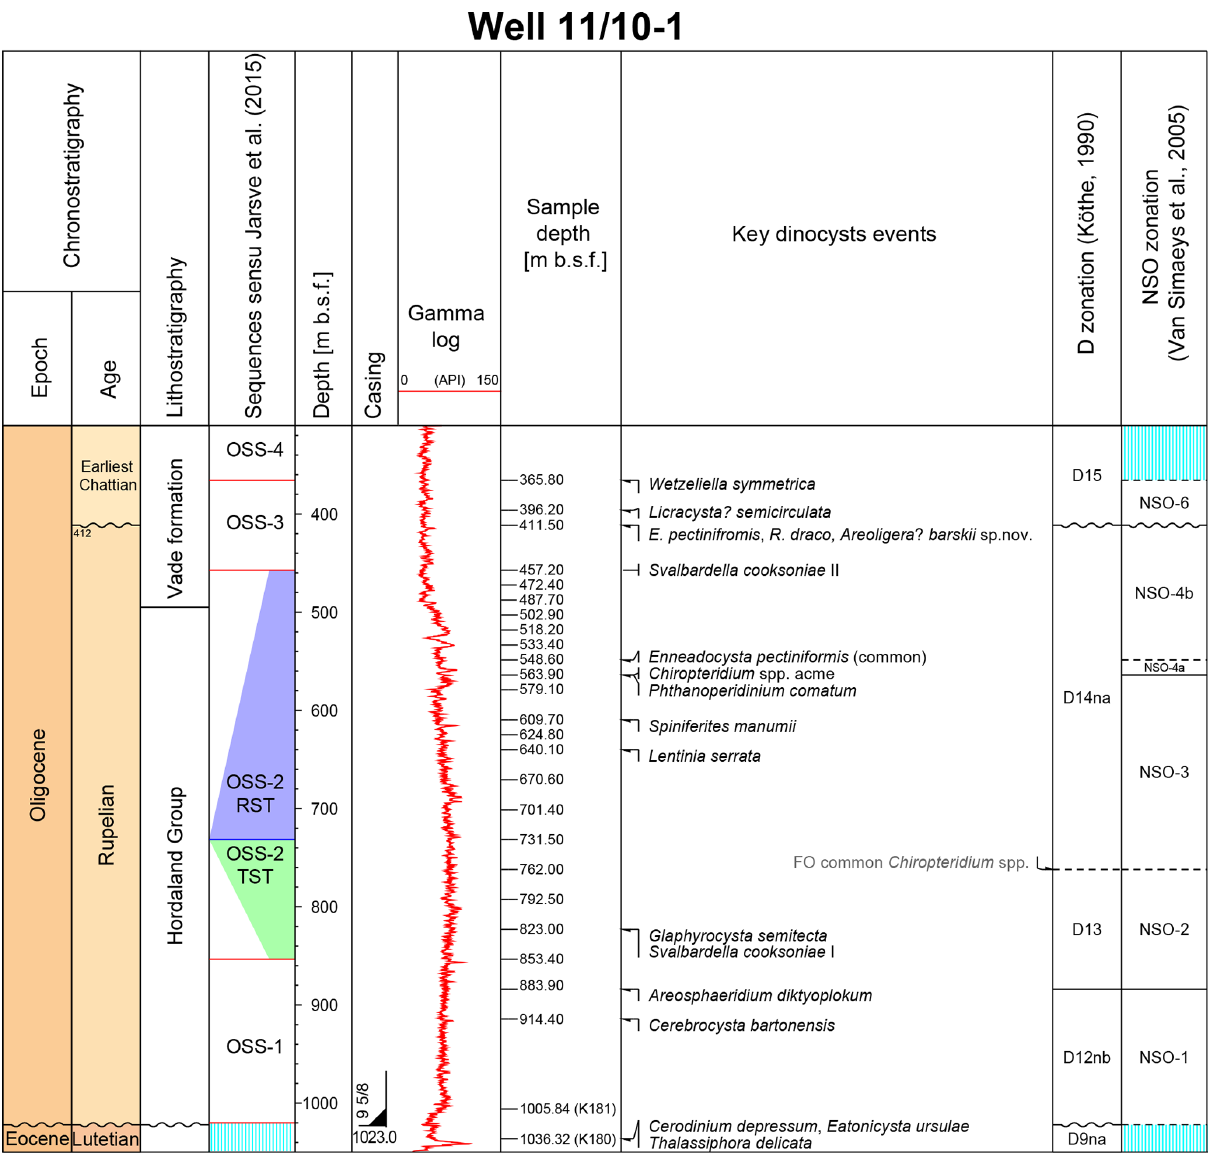
Figure 3. Chronostratigraphy (this study), lithostratigraphy and sequence stratigraphy (Jarsve et al., 2015), depth scale, casing and the gamma log of the studied succession in the 11/10-1 well are followed by key dinocyst events, the dinocyst zonal subdivision and the position of the studied samples (this